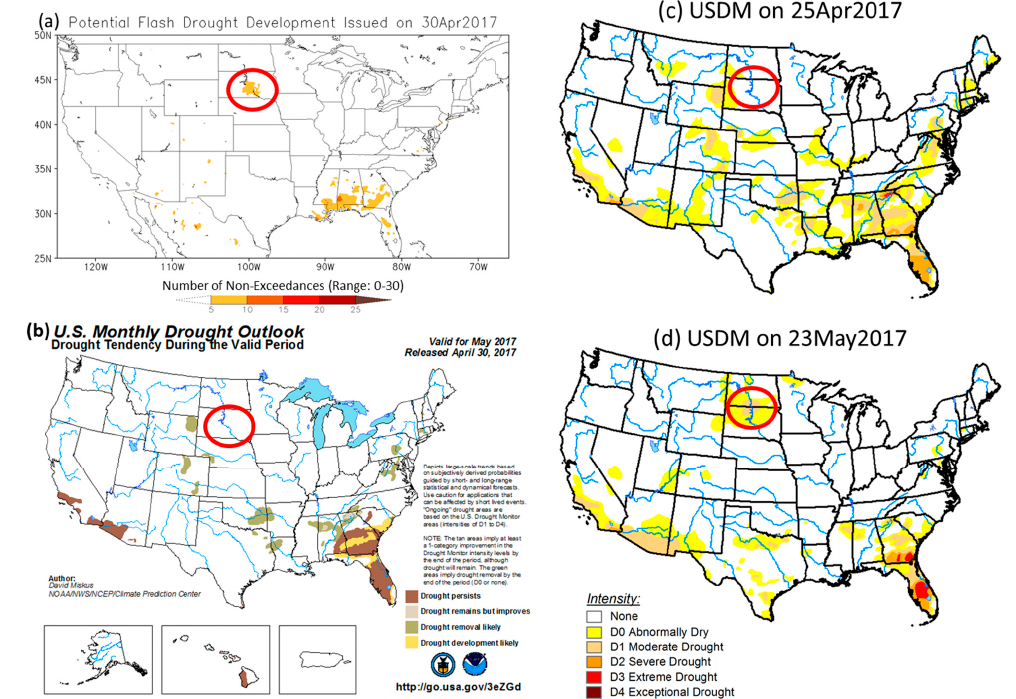
Figure 4. ( a ) Map of potential flash drought development issued on 30 April 2017, ( b ) Monthly Drought Outlook released on 30 April 2017, ( c ) U.S. Drought Monitor valid on 25 April 2017, and ( d ) U.S. Drought Monitor valid on 23 May 2017. Atmosphere 2020 , 11 , 1114